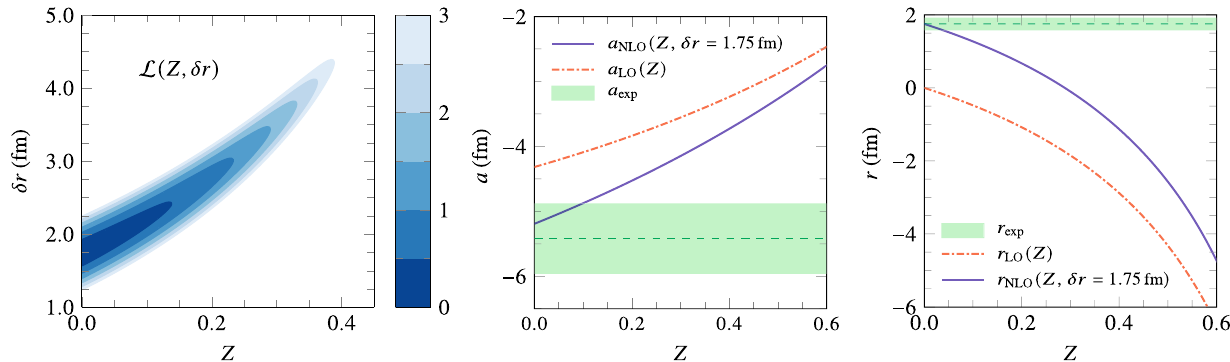
Fig. 1 Left: distribution of Eq. (6) for different values of the probabil- ity Z of ending the deuteron in a bare elementary particle, as a function of the NLO contribution δ r [Eq. (5a)] to the effective range of the pn